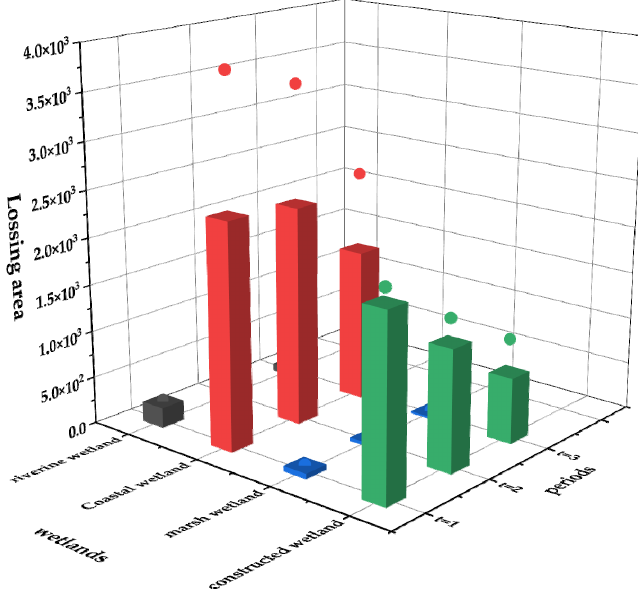
Figure 7. Loss of water ecosystem (wetland) area (10 4 m 2 ).